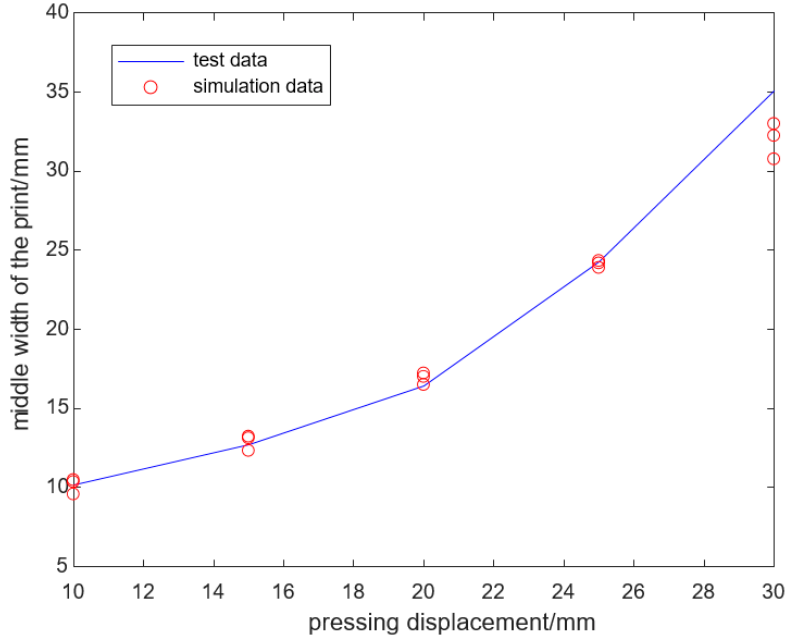
Figure 14. The comparison of the average value from the tests results and the simulation values from models meshed in different element size.